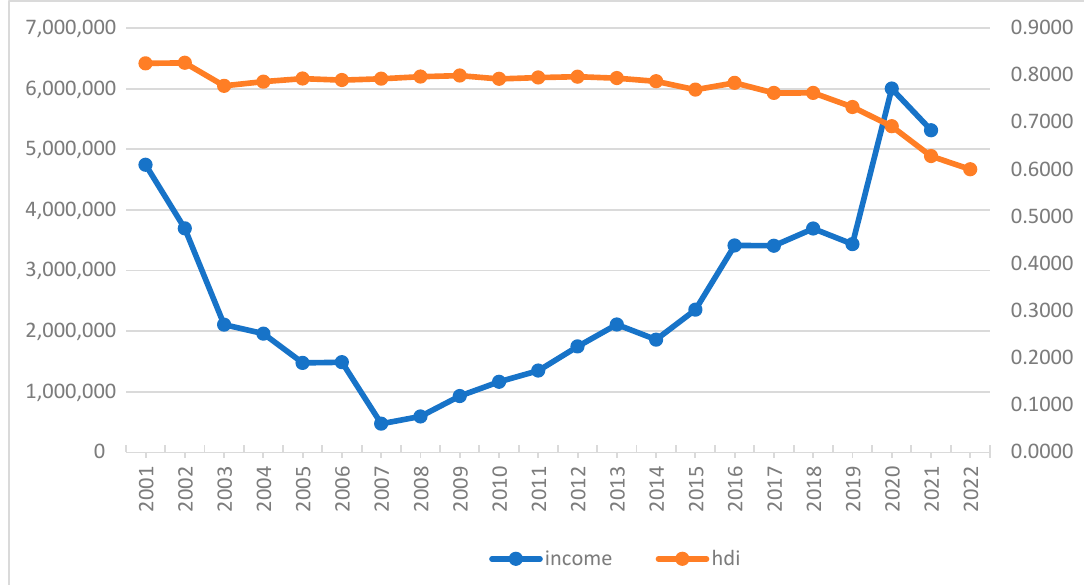
Figure 8. HDI and FRA Pampas 2000–2014. Source: DNCFP. In addition, the latest data published by UNDP for the whole country, also refers to the year 2013 and estimates an HDI of 0.808. For this year, no region reaches that value; only the northwest region reaches a value of 0.785 and Pampas region worth 0.787. Mean- while, the “Gran Chaco” again recorded in lower data with just 0.66.